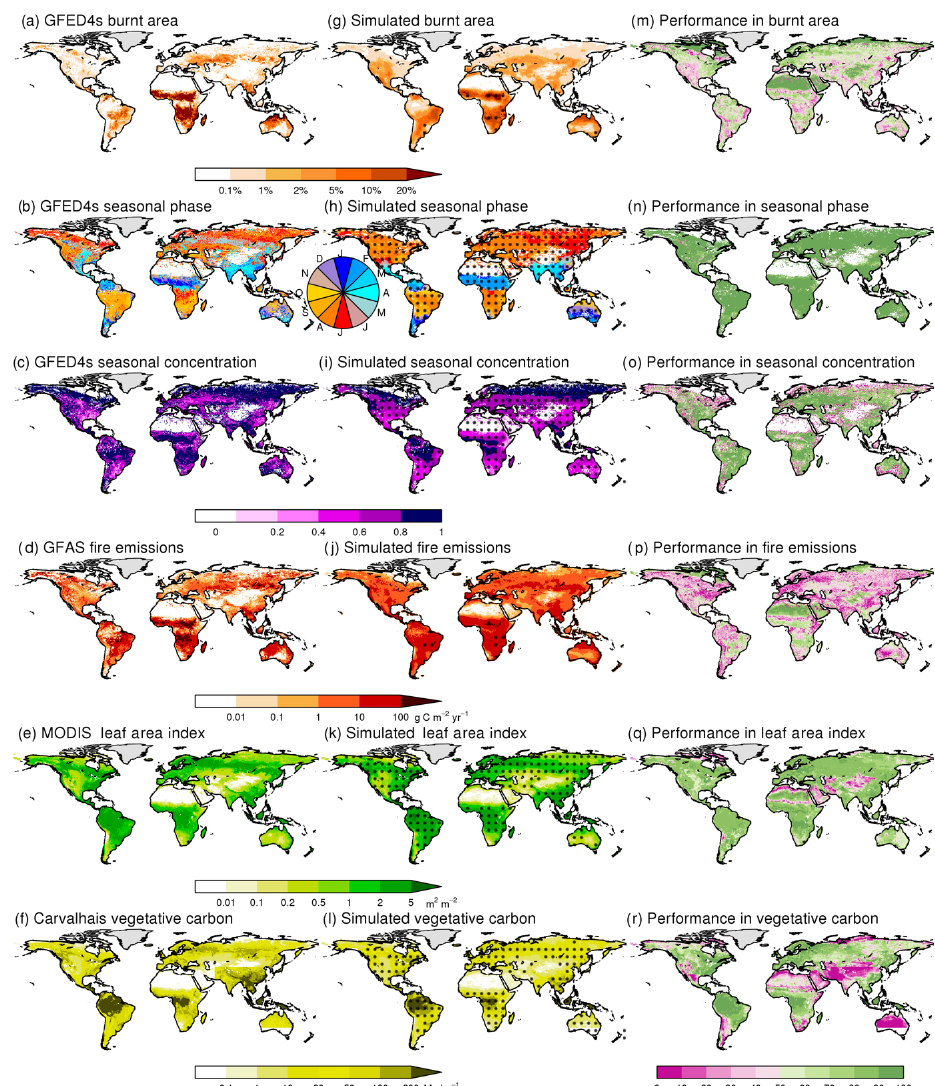
Figure 1. Reference datasets, the mean of all models and the percent of models for which the estimate falls within 50%–200% of the (mean) reference data are presented for a set of fire relevant variables. Results for the following variables are given as follows: (a) fraction burnt area, (b) seasonal timing of burnt area (as measured by mean phase), (c) burnt area season length (as measured by seasonal concentration), (d) fire C emissions (gCm − 2 yr − 1 ), (e) vegetation carbon (Mgha − 1 ) and (f) leaf area index (LAI) (m 2 m − 2 ). Stippling in the second column indicates where variance between models is less than the FireMIP model ensemble mean. Purple in the third column indicates cell where the majority of the FireMIP models produce poor simulations of the variable, while green areas indicate that the majority of the FireMIP models perform well for that aspect of the fire